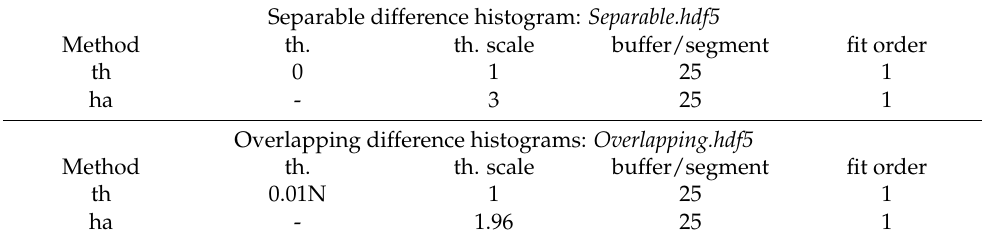
Table 2. Default reconstruction settings.